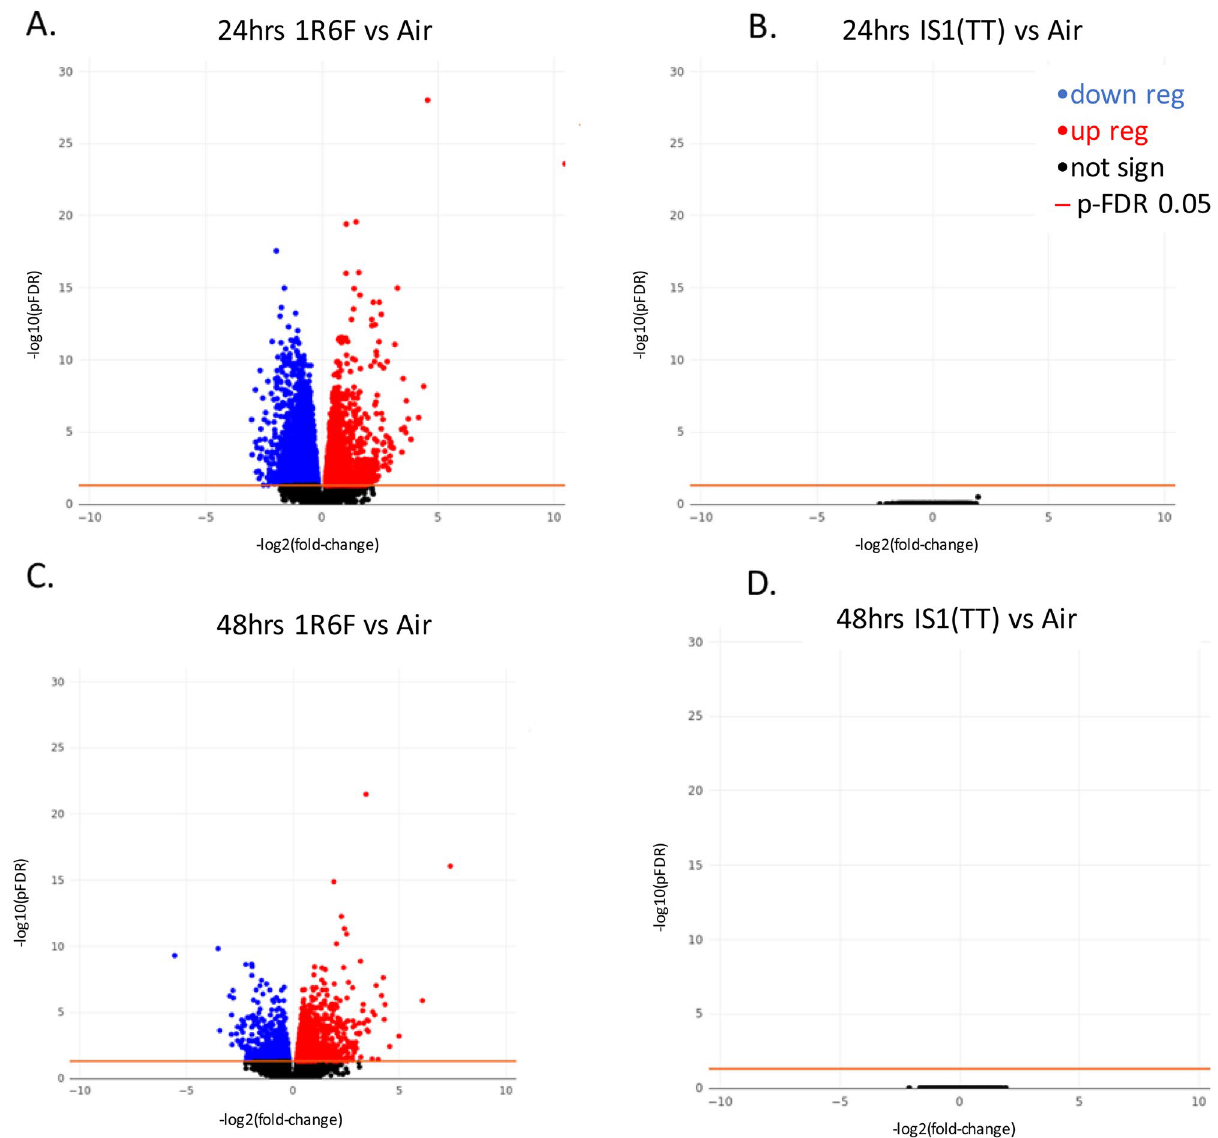
Figure 3. Volcano plots for the following 4 RNA-seq contrasts with pFDR < 0.05 threshold. 1R6F cigarette smoke exposure (1/30 dilution) vs air control, 24 hrs ( A ) and 48 hrs ( C ) post-exposure recovery, respectively. IS1 (TT) electronic cigarette aerosol exposure (1/3 dilution) vs air control, 24 hrs ( B ) and 48 hrs ( D ) post- exposure recovery, criminate the IL-13 treated samples from the untreated samples (Fig. 4C,D and Supplementary Fig. S8). For all four KE genesets (KE1, KE2-3, KE4, KE5) clustering was observed based on treatment. iii. Human COPD lung tissue biopsies. This study analyses the expression levels of "Mucus Hypersecretion" AOP-associated genes in lung tissue samples obtained from 98 patients with COPD and 91 non-COPD subjects. All subjects had been diagnosed with lung cancer. RNA-seq dataset from lung biopsies col- lected during this study were downloaded from SRA PRJNA245811 19 . Exploratory analysis revealed that subjects cluster by tissue disease status (COPD vs normal) on the second principal component (Fig. 5A). Heatmaps of tissue-specific expression levels of "Mucus Hypersecretion" AOP-related genes showed no obvious clustering of lung tissue samples by their disease status (Fig. 5B). Principle component analy- sis (PCA) analyses revealed a potential disease status-effect on the expression of KE-associated genes (Fig. 6A), however, the affected principal components (second, third or fourth) were also influenced by confounding technical factors/quality of sequencing (perc gene, perc unmapped) (Fig. 6B). Perc_gene and perc_unmapped are percentage of read-pairs mapped to one location in the genome and unambiguously associated with a single gene and percentage of read-pairs not mapped to any location in the genome, respectively. Therefore, it is not possible to conclude what is driving the separation.